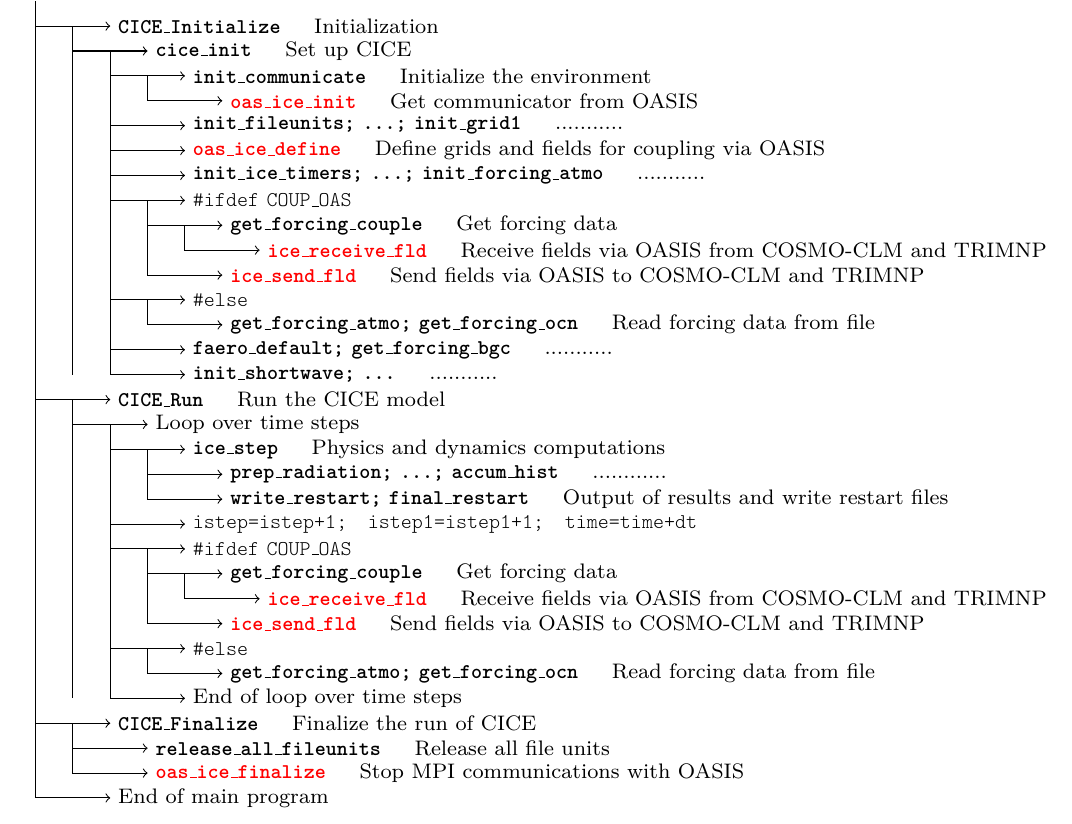
Figure 11. As Fig. 8 but for the CICE sea ice